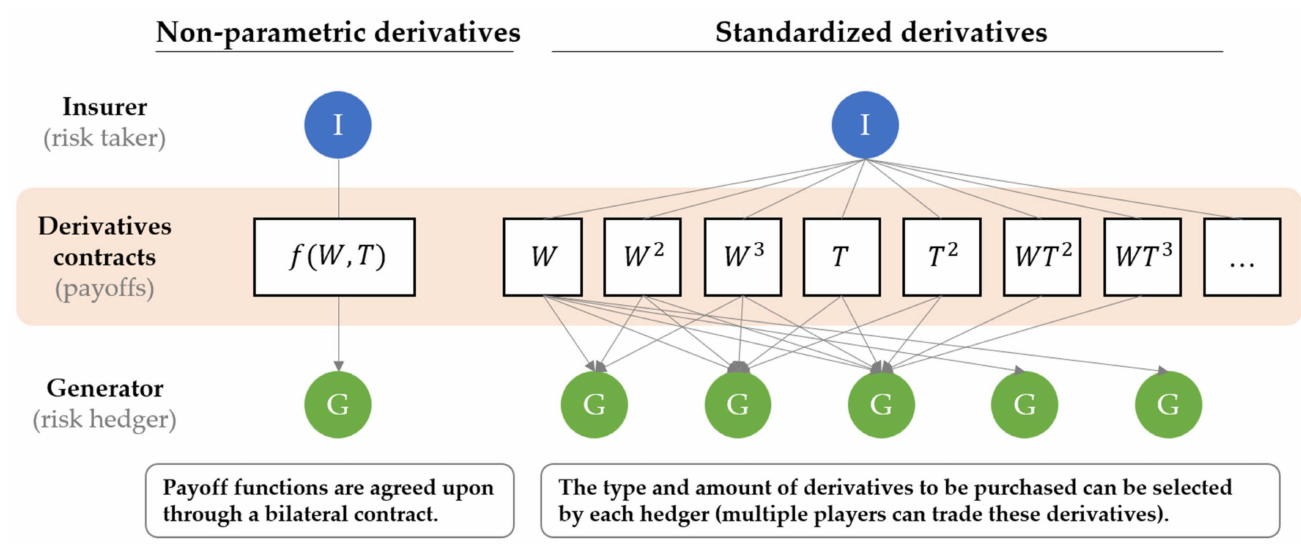
Figure 2. Market trading model for wind derivatives. Note: “ W ” represents wind speed index and “ T ” represents temperature